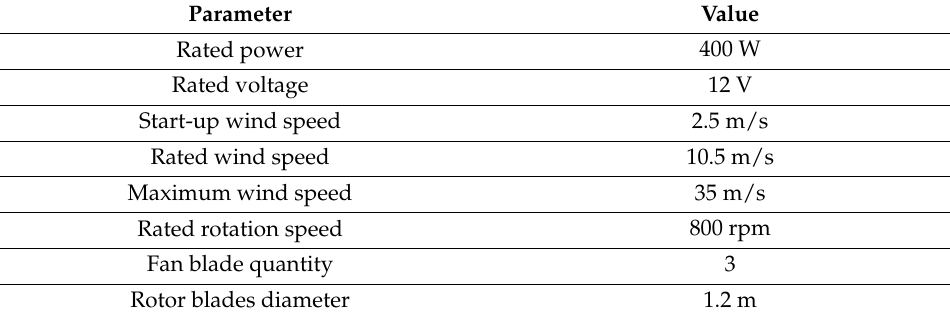
Table 5. Wind generator parameters